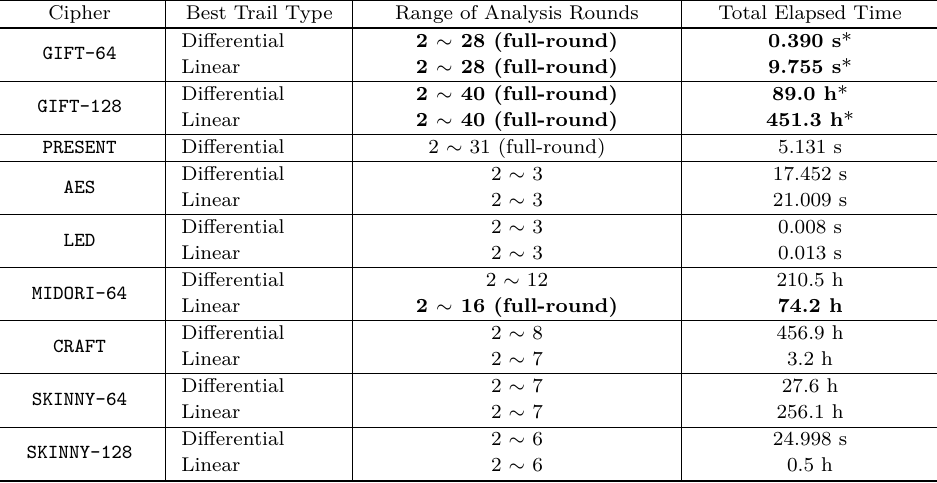
Table 1: Summary of Best Trail Searches on the Considered